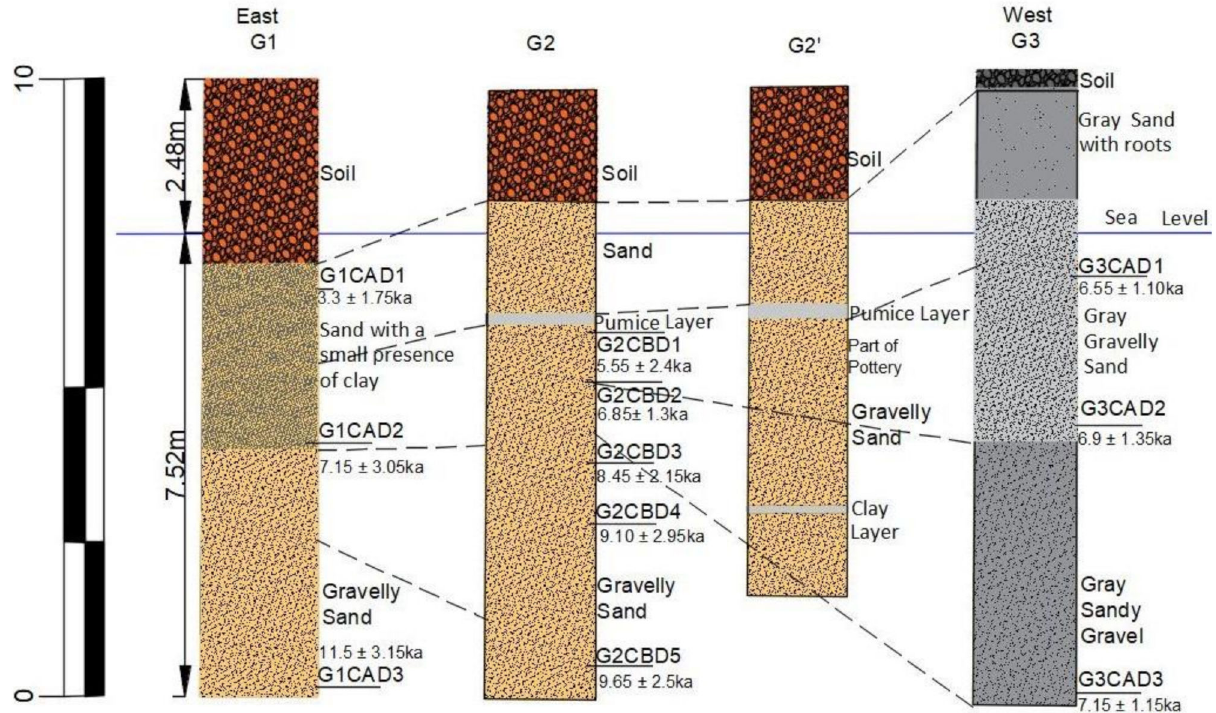
Figure 6. Stratigraphy of the drilling cores depth of samples and correlations between the various layers of